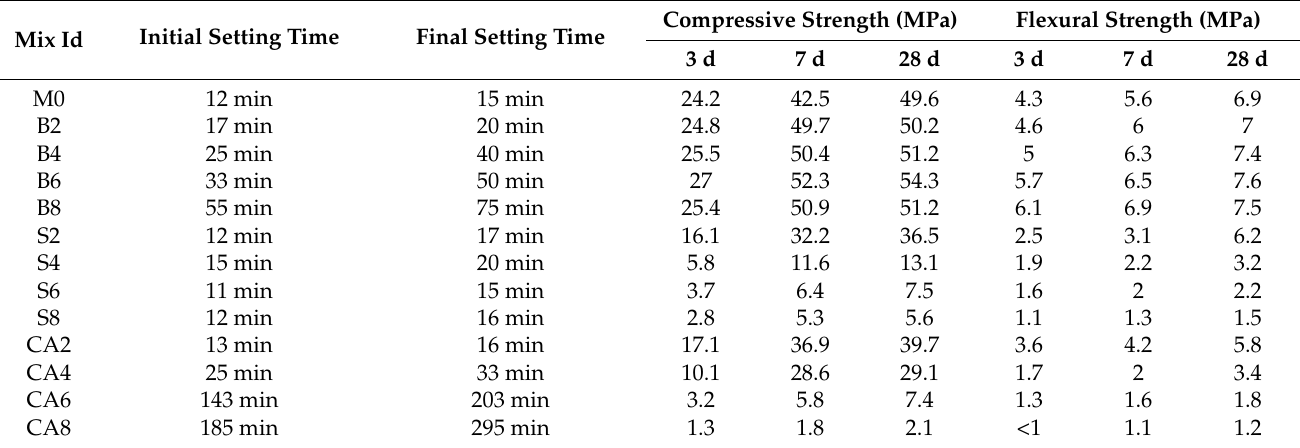
Table 3. Testing results of different parameter